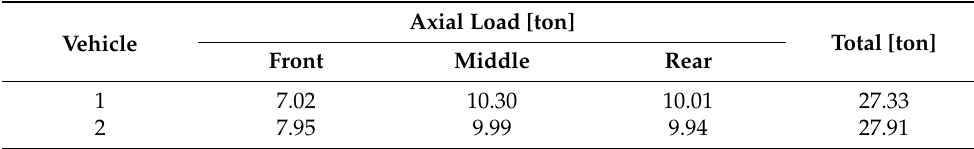
Figure 5. Specifications of the vehicles used in the vehicle loading test. Table 1. Weight of the vehicles used in the vehicle loading test.